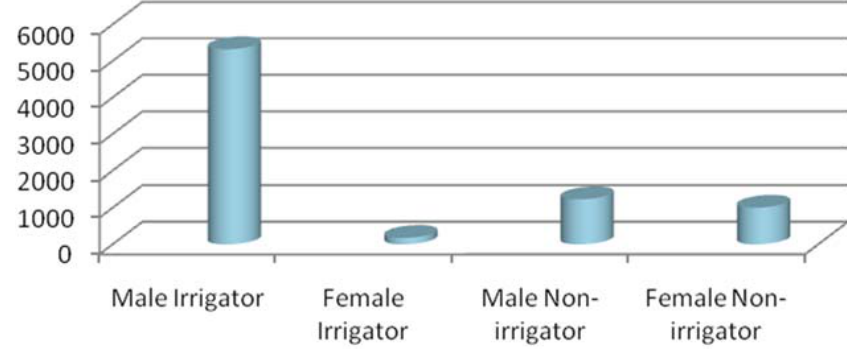
Figure 5. HHs off ‐ farm income. Figure 5. HHs off-farm